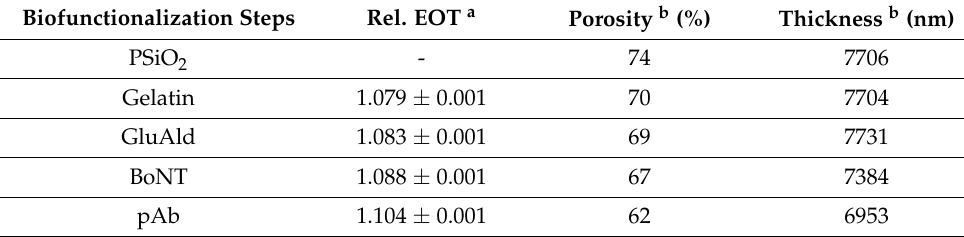
Figure 2. Biofunctionalization characterization using RIFTS. ( a ) Reflectivity spectra and ( b ) the corresponding FFT following different biofunctionalization steps (i.e., gelatin, GluAld, BoNT, pAb). Table 1. BoNT-C toxoid biofunctionalization characterization using RIFTS and SLIM.